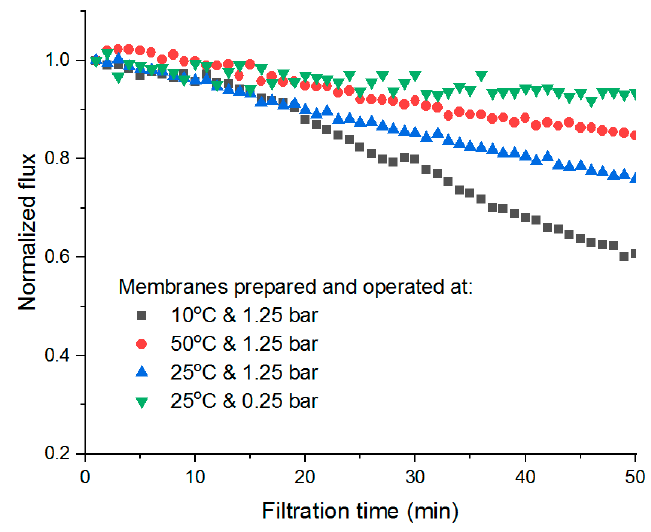
Figure 11. Flux decrease in PVDF-TiO 2 membranes due to compression.